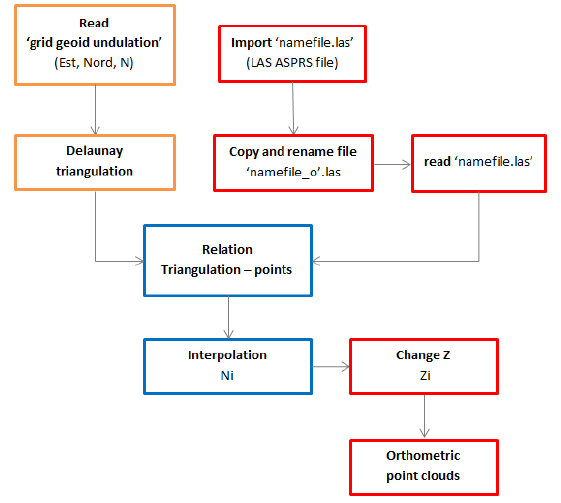
Figure 3. Flow chart of